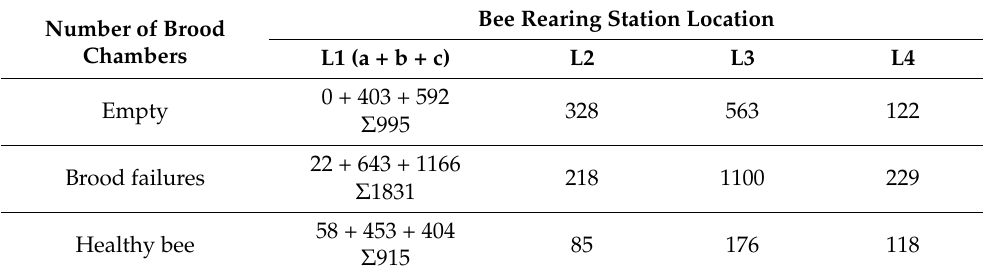
Table 1. Comparison of the number of empty brood chambers with those which contain healthy Osmia spp. adult bees, and with rearing brood failures, in locations with different environment.